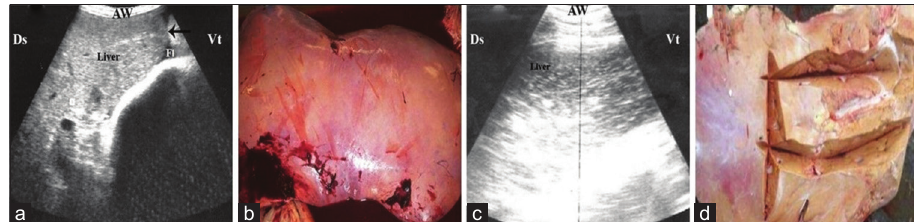
Figure-3: (a) Ultrasonography (US) of a liver at the level of the right 8 th ICS shows a mild degree of fatty liver, note the narrow veins, rounded edge (arrow), and scanty amount of anechoic fluid (Fl). (b) Necropsy of a diffuse mild fatty lesion with brownish-yellow color. (c) US of a liver at the levels of the right 10 th ICS shows severe fatty infiltration. The hepatic parenchyma appears more echogenic with invisible veins. (d) Necropsy of severe diffuse fatty liver which appears yellowish in color and friable in consistency. AW=Abdominal wall, Ds=Dorsal,